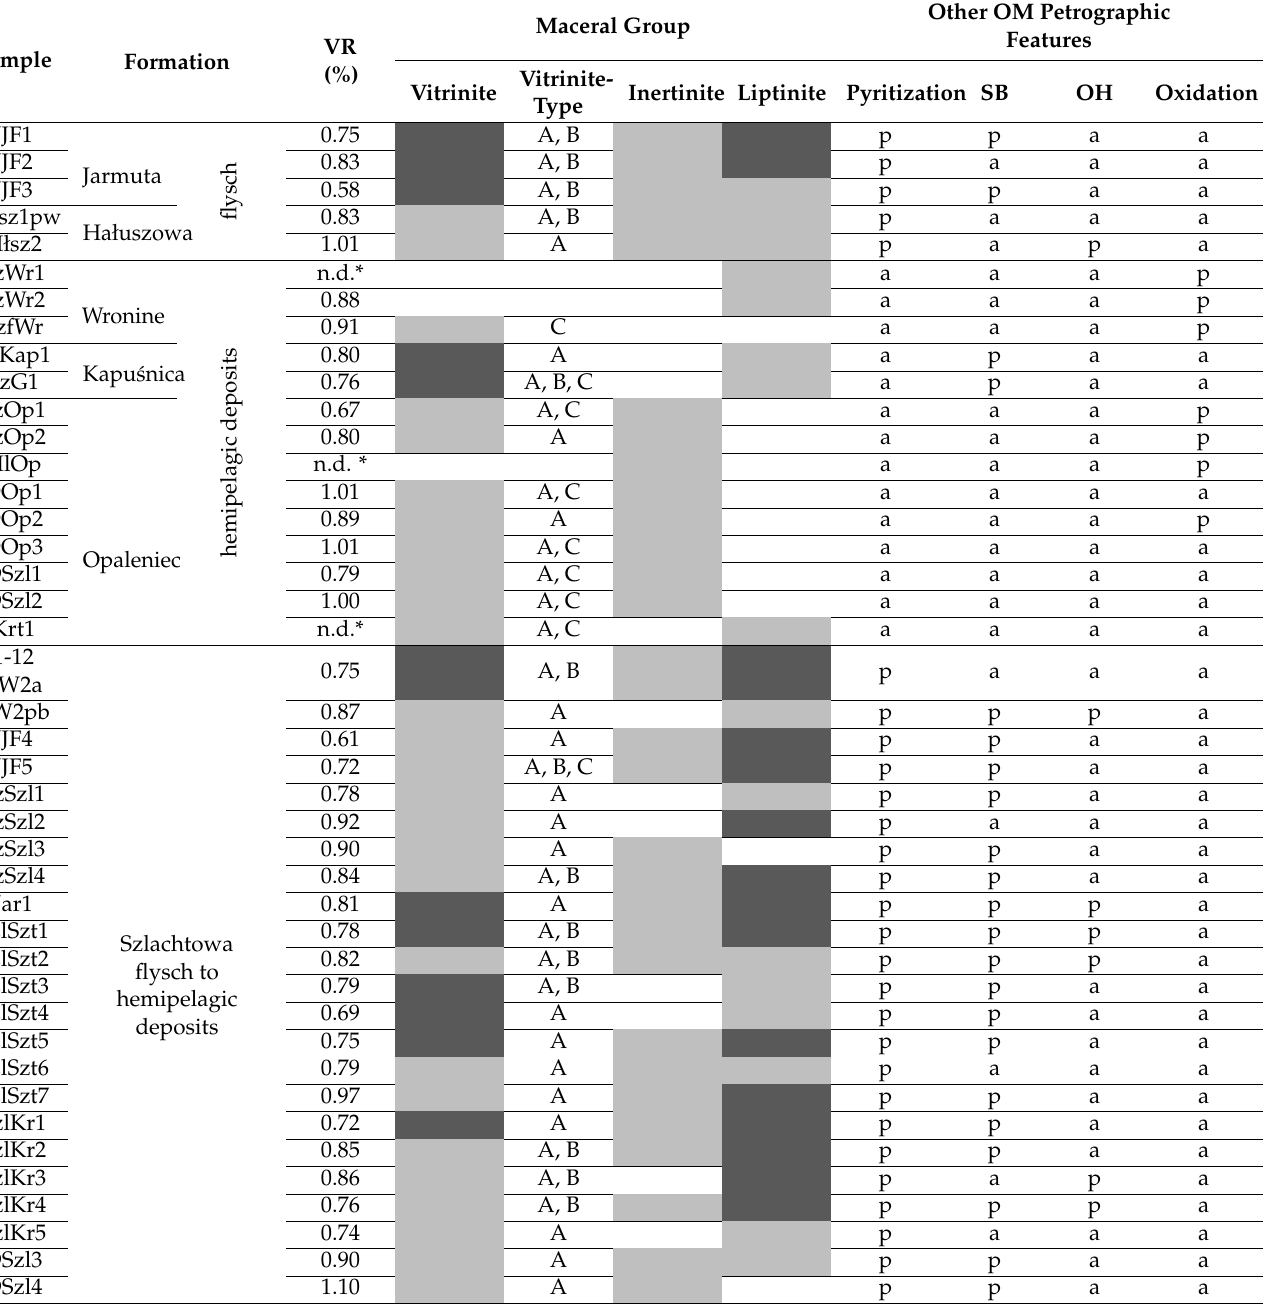
Table 1. Qualitative organic petrography